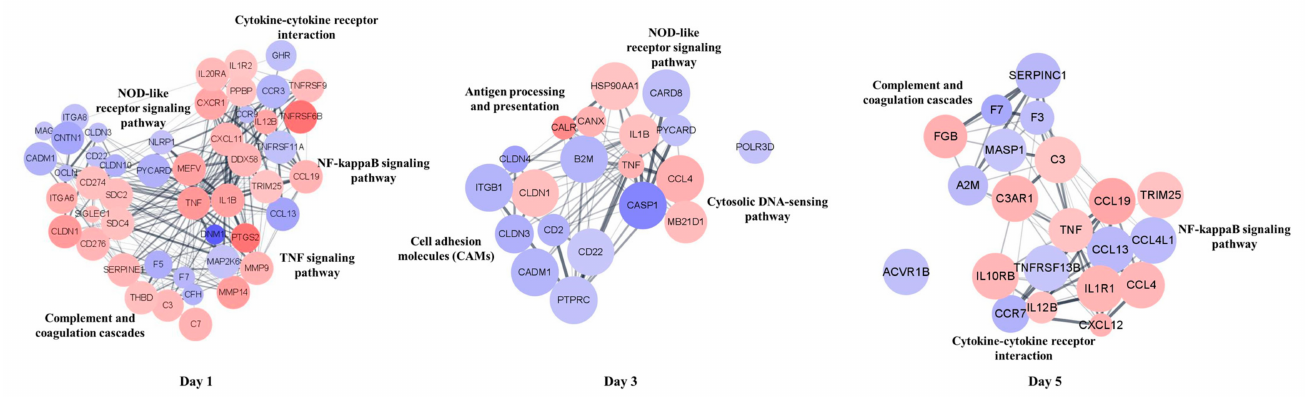
Figure 3. Protein–protein interaction (PPI) networks of immune-related DEGs at days 1, 3, and 5. Nodes represent genes, and links represent networks (genes can be linked by more than one type of network). Proteins are represented by nodes, and interactions are represented by edges. The number of edges is related to the strength of the interaction. The red and blue colors represent the upregulated and downregulated genes. The size of the node is inversely proportional to the p -value.